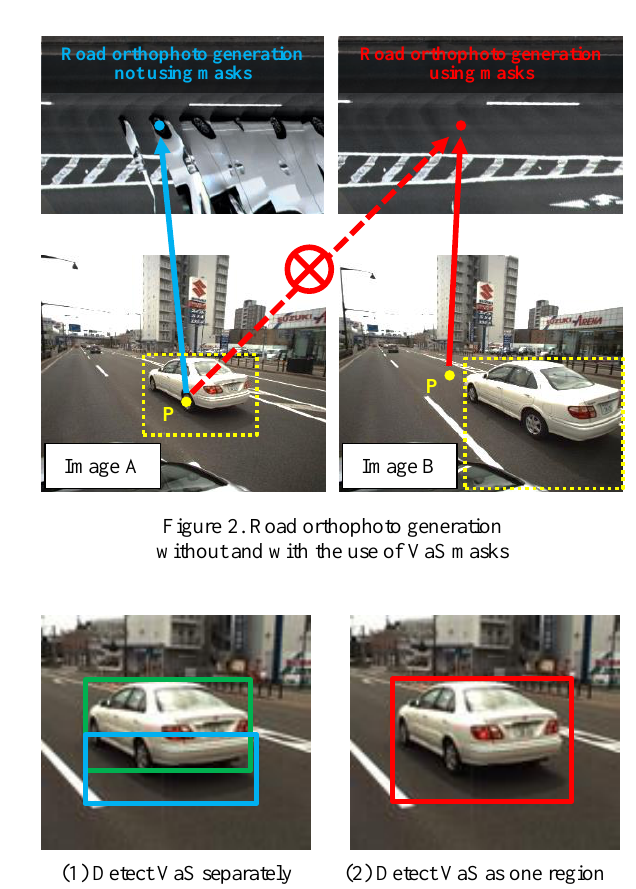
Figure 1. Generation of high-definition road orthophoto using images and point clouds acquired from MMSs